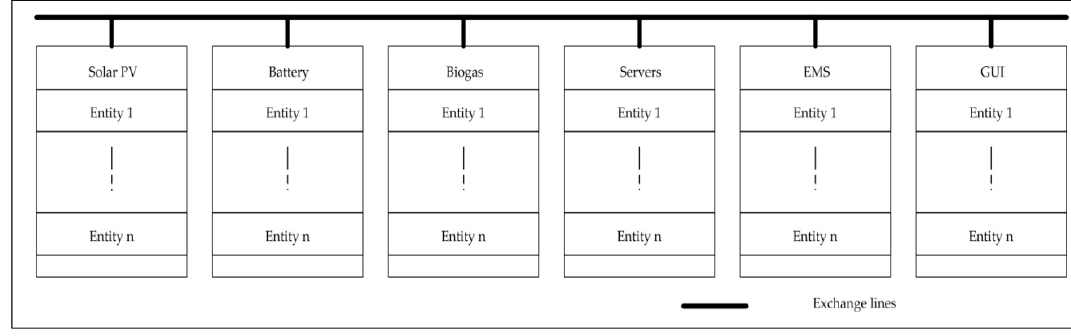
Figure 9. The configuration concept for the VPP (as given [42]).